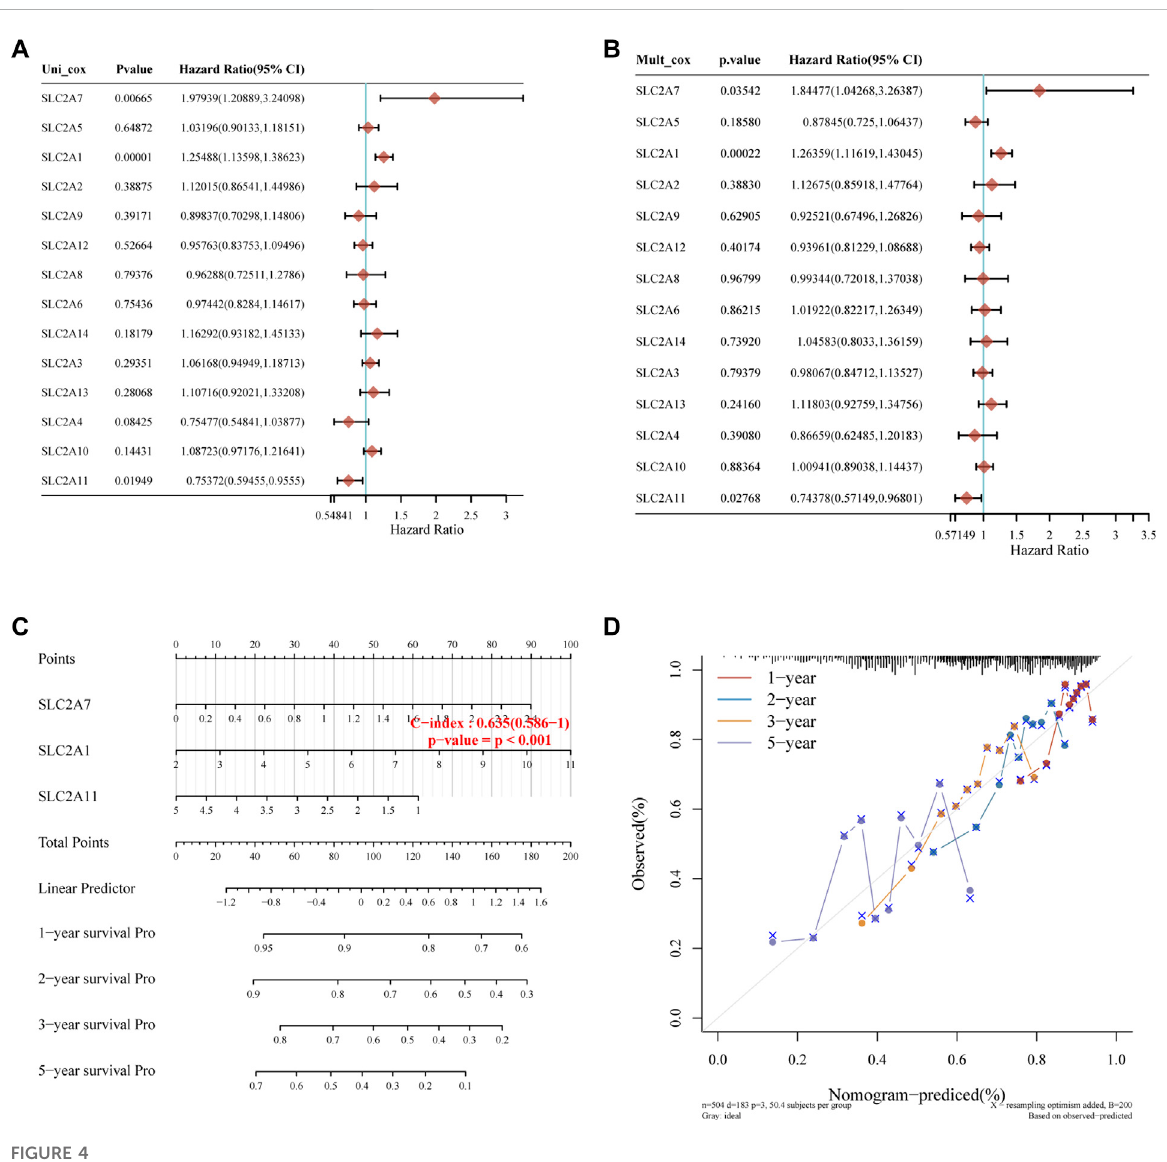
and orange line indicate the 1-year, 2-year, 3-year, and 5-year of the observed nomogram, respectively. This suggests that the prognostic model could successfully predict the prognosis of LUAD. The dashed diagonal line represents the ideal